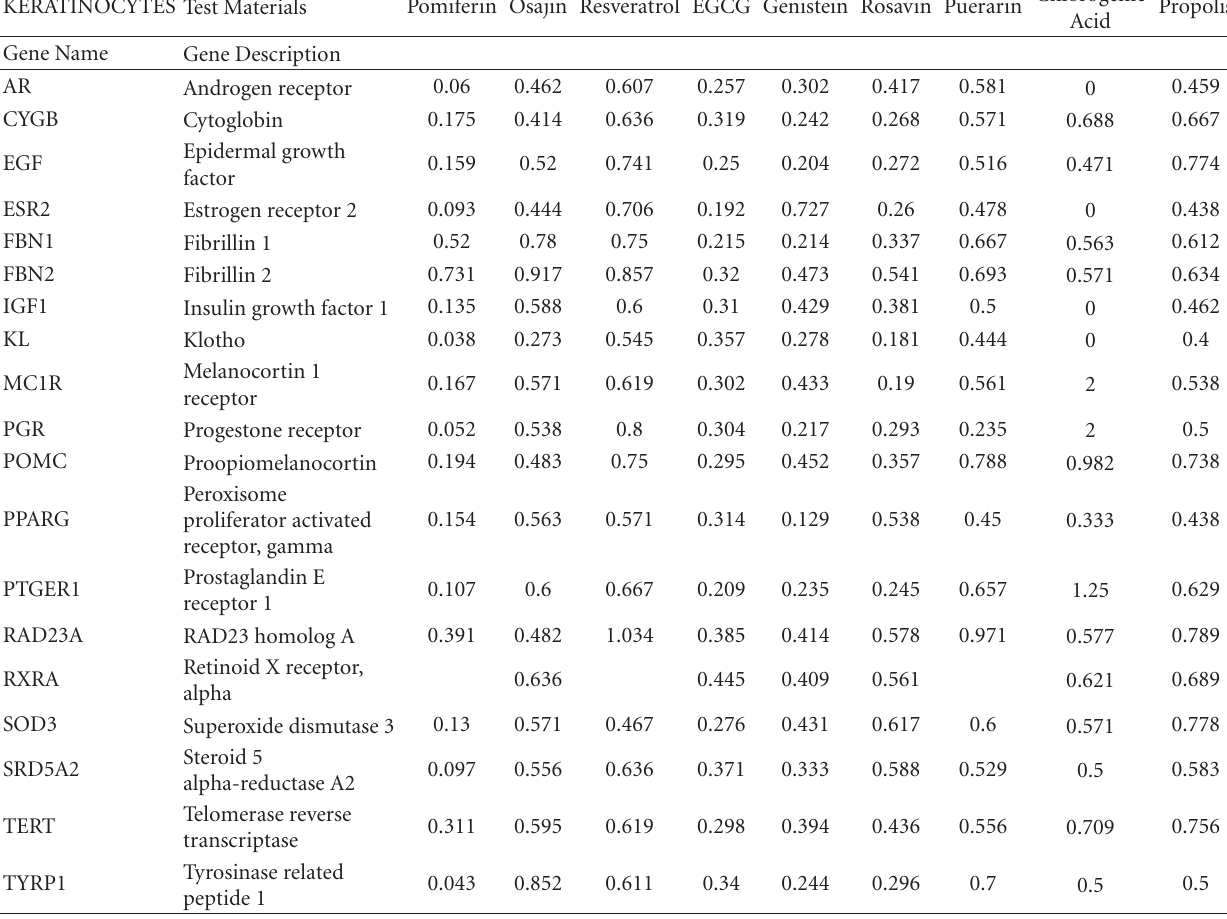
Table 6: Summary of keratinocyte genes noted to be commonly downregulated by the antioxidant treatments. KERATINOCYTES Test Materials